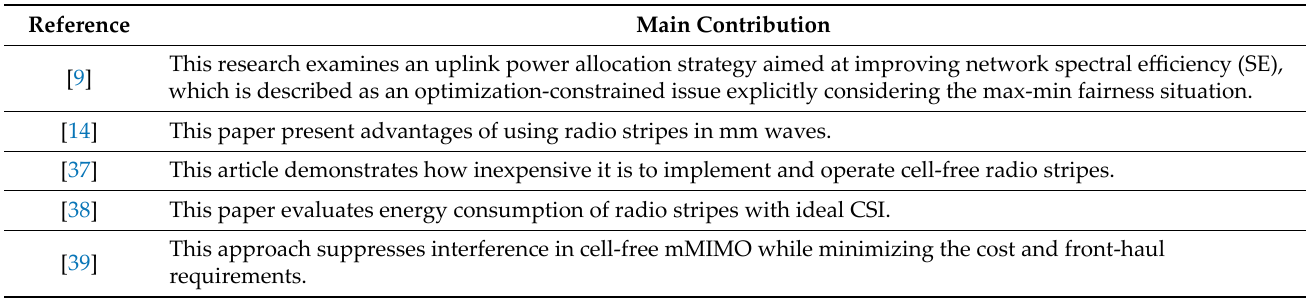
Table 3. Representative Overview of Recent Studies on Radio Stripes.